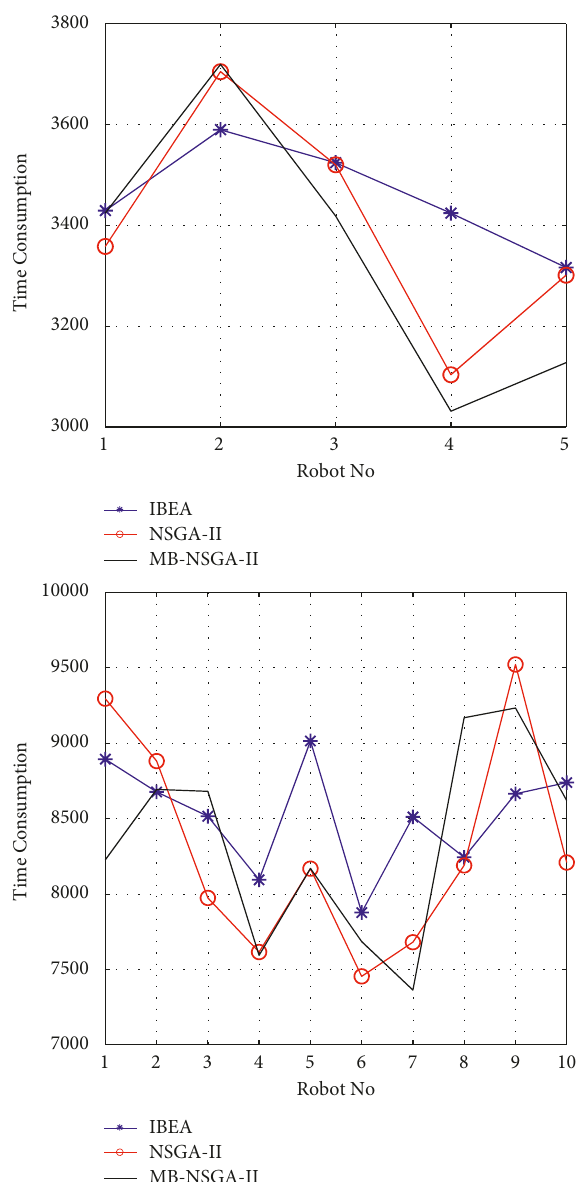
Figure 6: Schematic diagram of the average time consumed by robots to perform